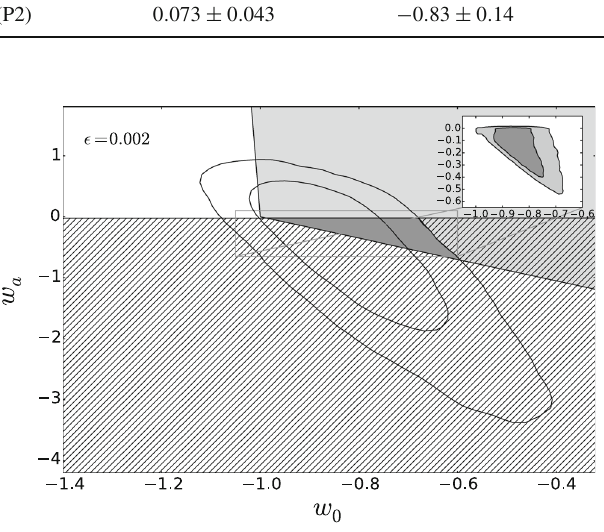
Fig. 3 Left panel Confidence contours (68.3% and the 95.4%) on the w 0 − w a plane for parameterisation P1. The hatched and shaded regions correspond to the first and second sets of thermodynamic con- straints, respectively. The confidence contours and the thermodynamic constraints assume (cid:7) = 0 . 002. Right panel The same as in the previous